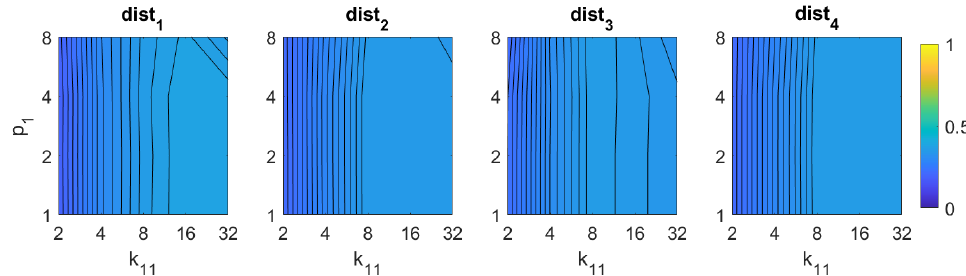
Figure 10. BG image retrieval problem. Success rate of the method. k 10 is the number of horizontal cells and w 2 the number of windows per cell (Table 1).